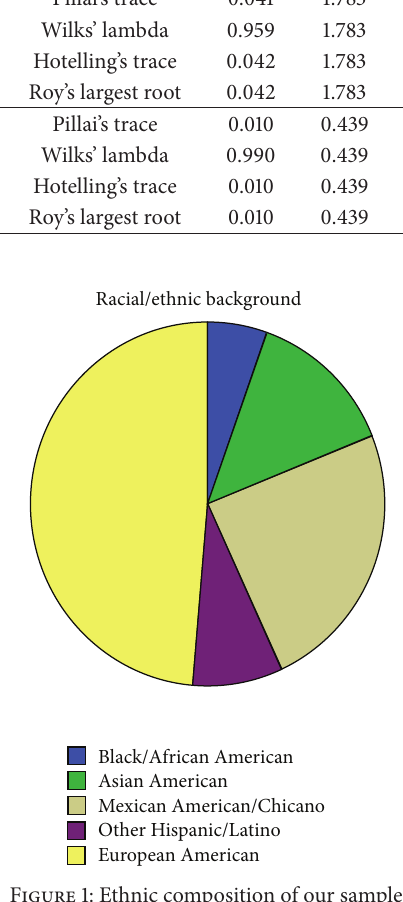
Figure 1: Ethnic composition of our